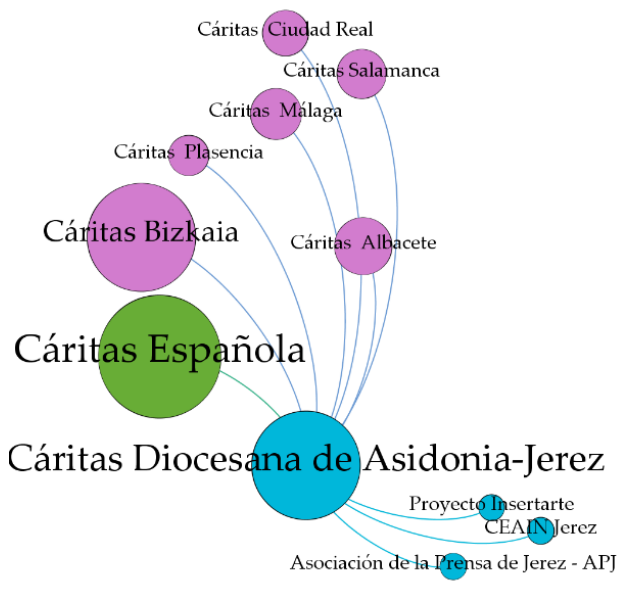
Figure 4. Display of the CAJ’s Facebook network with a “Mutual Edge” filter.